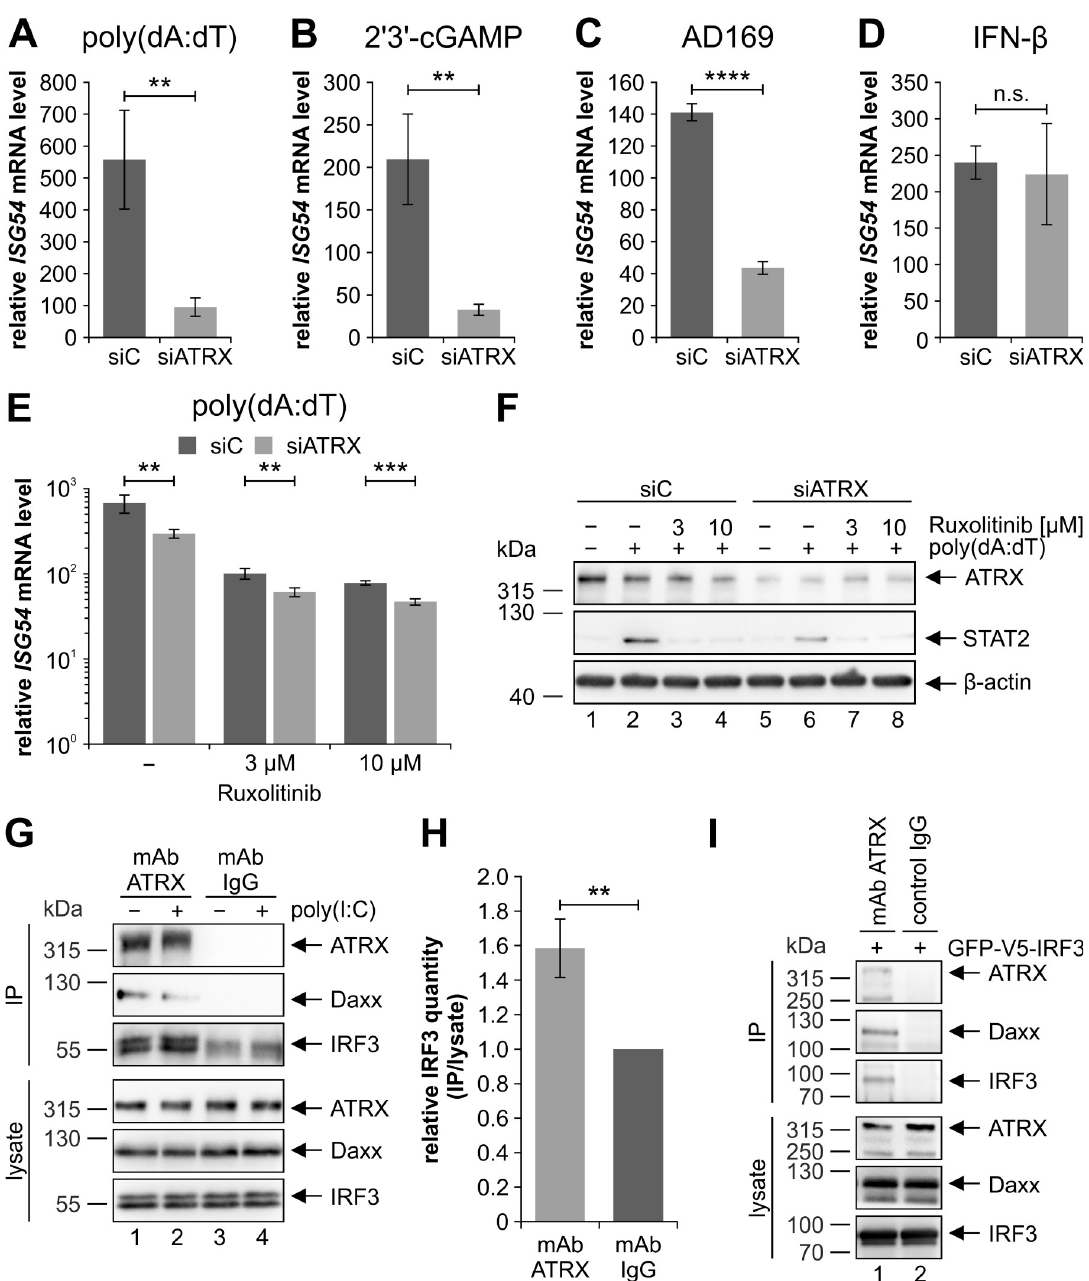
Fig 3. ATRX interacts with IRF3 and modulates IRF3 activity. Stable ATRX knockdown HFFs (siATRX) and respective control HFFs (siC) were (A) treated with DMSO and 0.1 μ g/ml poly(dA:dT) for 24 h, (B) treated with 50 μ g/ml 2’3’-cGAMP for 24 h, (C) infected with the laboratory HCMV strain AD169 (MOI of 1) for 8 h or (D) treated with 3.28 × 10 3 U/ml IFN- β for 24 h. (E+F) Alternatively, cells were treated with 0.1 μ g/ml poly(dA:dT) and 3 μ M or 10 μ M Ruxolitinib for 24 h. (A-E) Total RNAs were prepared and RT-qPCR was performed to determine transcription of the IRF3-responsive gene ISG54 . Depicted values were calculated from triplicates relative to untreated siC cells using ACTB or GAPDH as housekeeping genes and are shown as mean ± SD. One out of at least two independent experiments is shown. Statistical analysis was performed with respective Δ Cq-values using a student’s t -test (unpaired, two-tailed); n.s.: not significant, �� p < 0.01, ��� p < 0.001, ���� p < 0.0001. (F) Cells were harvested for Western Blot analyses to determine STAT2 expression; β -actin served as internal loading control. The following antibodies were used: anti-ATRX (HPA001906), anti-STAT2 (A7), anti- β -actin (AC-15). (G-I) HEK293T cells were (G) stimulated with 0.5 μ g/ml poly(I:C) or (I) transfected with a plasmid coding for GFP-V5-IRF3. After 24 h, cells were immunoprecipitated with an ATRX antibody (D1N2E) or an IgG isotype control antibody. The following antibodies were used for detection of proteins in the immunoprecipitate (IP) and in the whole cell lysate (lysate):